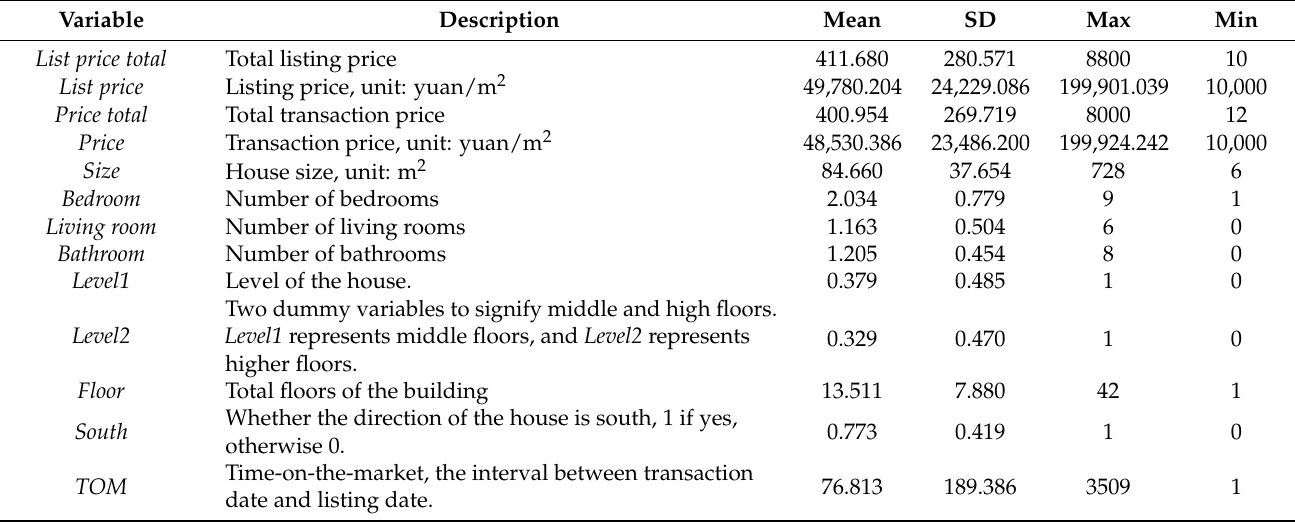
Table 1. Transaction data and descriptive